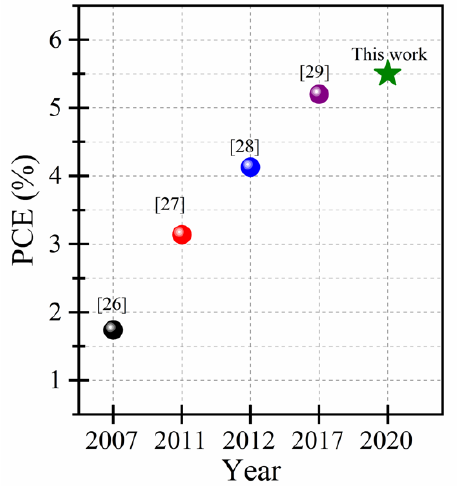
Figure 6. Progress achieved in the power conversion e ffi ciency for PLD-CZTS-based solar cells over the (2007–2020) time period. The green star corresponds to the average PCE achieved in this work.